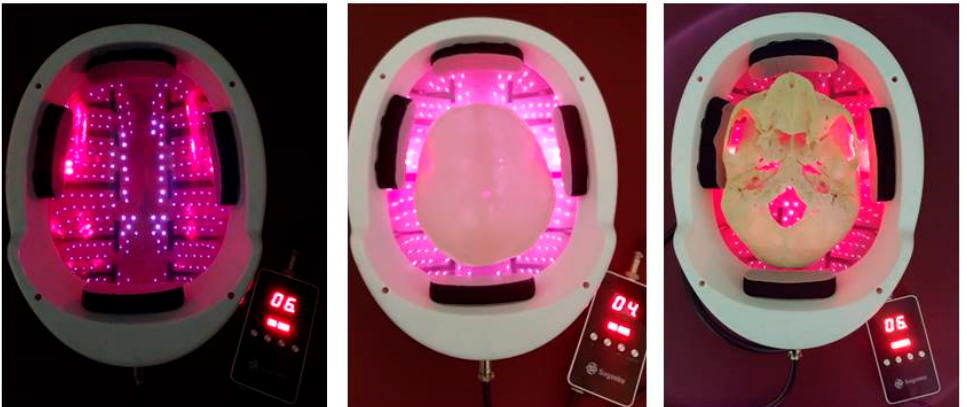
Figure 2. Helmet from Suyzeko (Shenzhen, China) for possible brain photobiomodulation therapy (3 January, 2019).